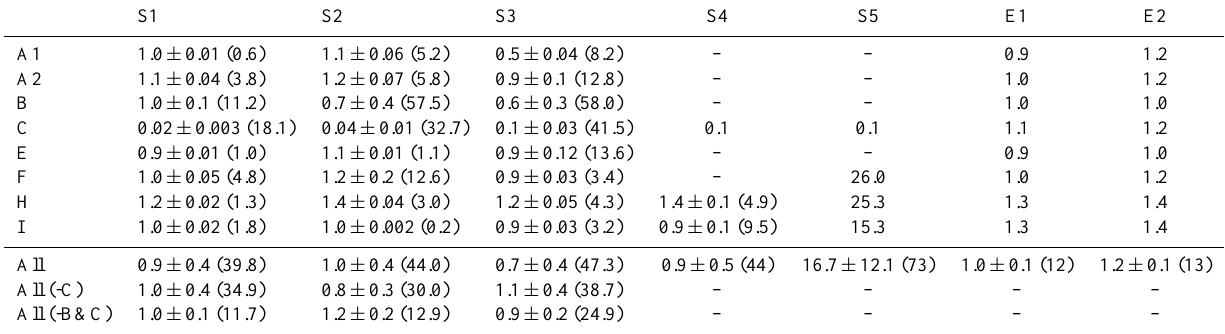
Table 5. Summary of DIP 25 ratios for all sediments and laboratories. Values correspond to mean ± sd (%RSD) and are either expressed to